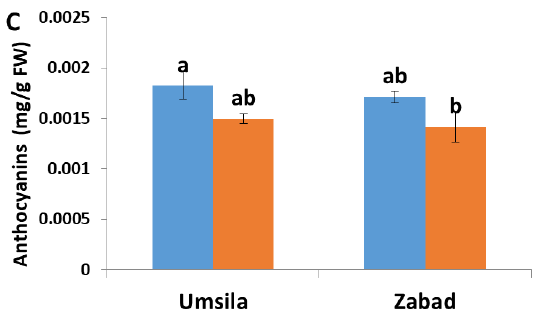
Figure 2. The effect of salinity on the total chlorophyll ( A ), total carotenoid ( B ), and anthocyanin concentrations ( C ) in date palm seedlings when subjected to control (0 mM NaCl) and salinity (240 mM NaCl) conditions. Bars represent the mean ± SE ( n = 3).